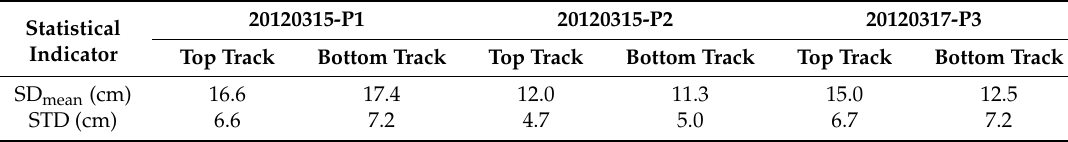
Table 4. OIB SD statistics within three 25 km pixels (P1, P2 and P3 in Figure 2). SD mean and STD are the mean value and the standard deviation and of OIB